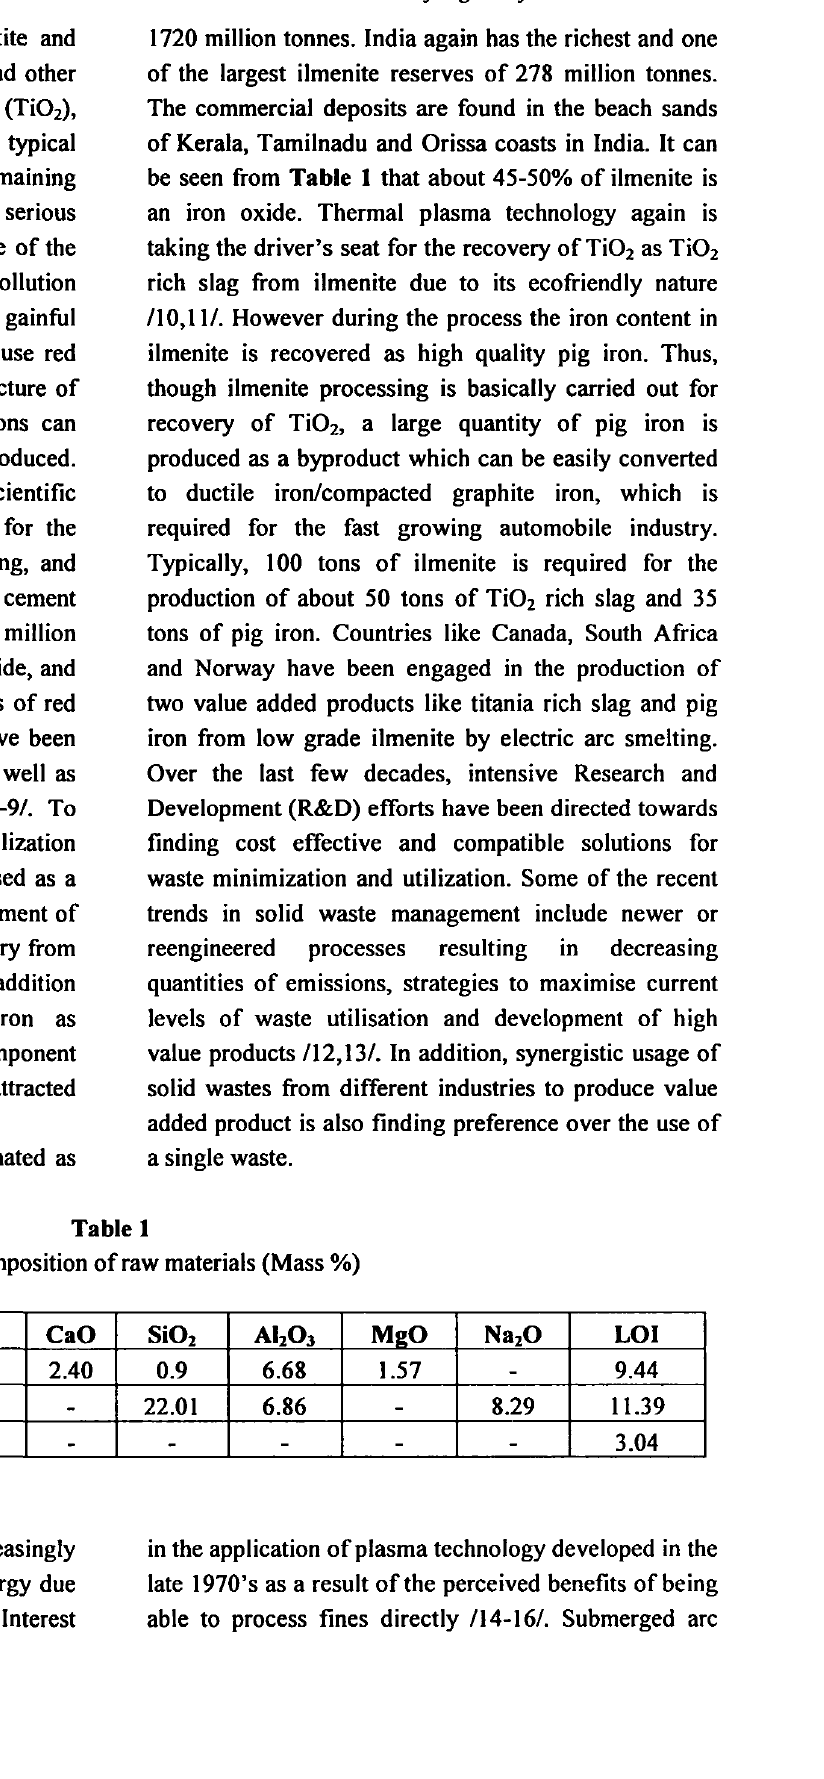
Chemical composition of raw materials (Mass